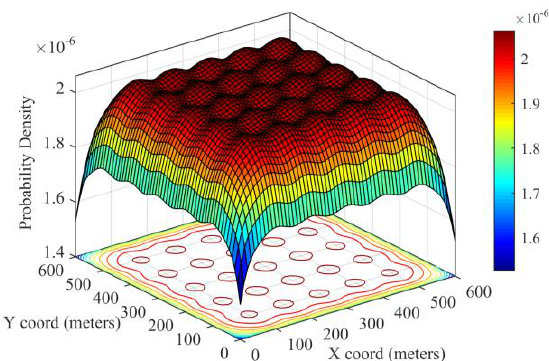
Figure 2. The overall probability distribution over the entire deployment region.